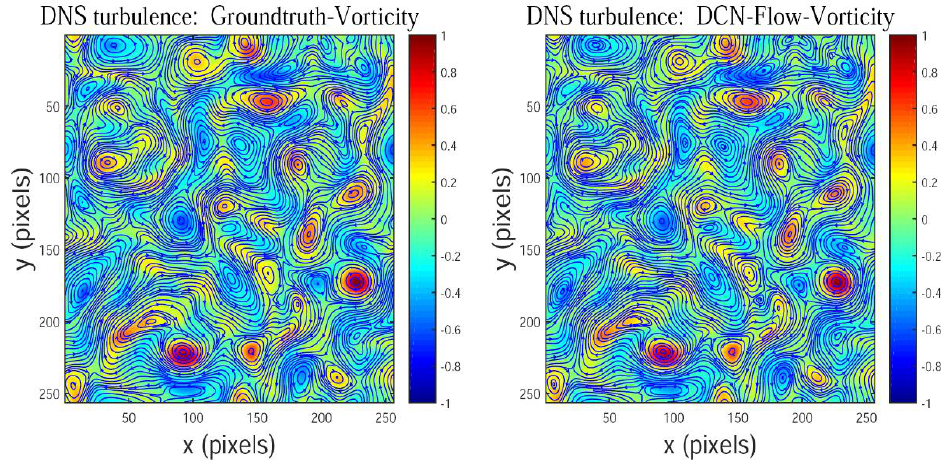
Figure 9. The color-coded vorticity field of DNS-turbulence estimated by our method (DCN-Flow).